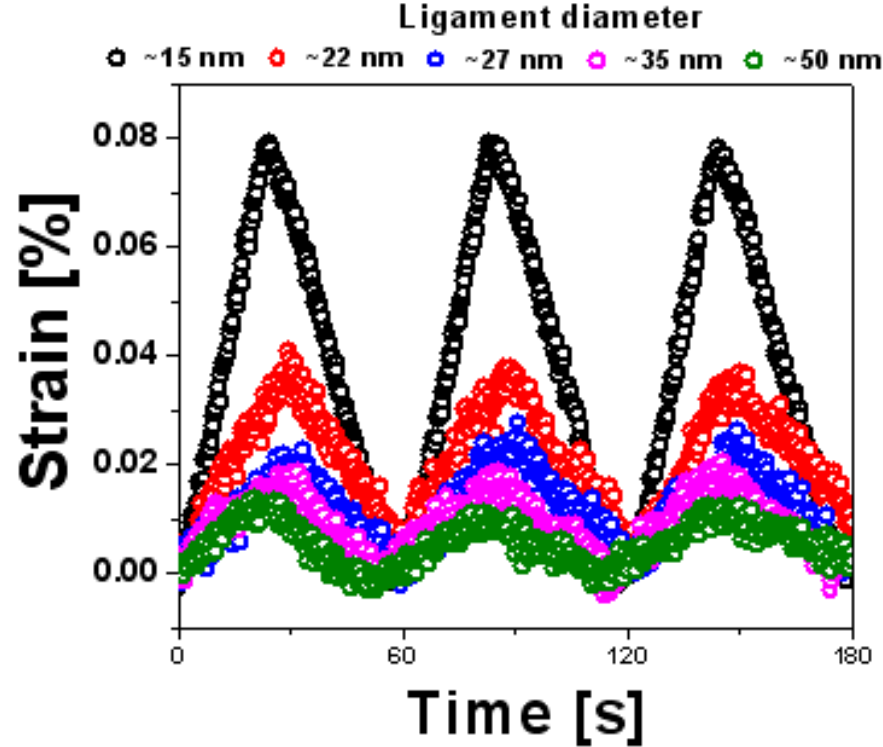
Figure 4. Ligament size-dependence of the charge-induced strain in nanoporous metals (Au). The strain amplitude that was recorded on five specimens with different ligament sizes decreased with increasing ligament size. This shows that ligament growth during electrochemical actuation is undesirable [67,68].